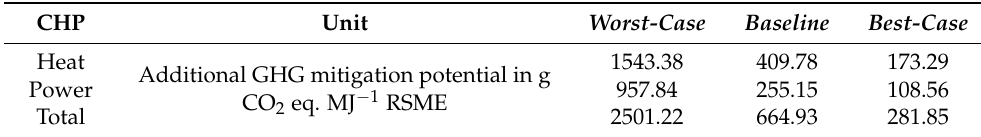
Figure 4. GHG emissions from rubber seed-based biodiesel production in g CO 2 eq. MJ − 1 RSME applying the by-product scenario (i.e., use of rubber wood, seed shells and press cake to generate internal process energy and organic fertilizer). Table 7. Additional GHG mitigation potential through substitution of fossil-energy sources by heat and electricity generated through combustion of rubber seed by-products under three scenarios.